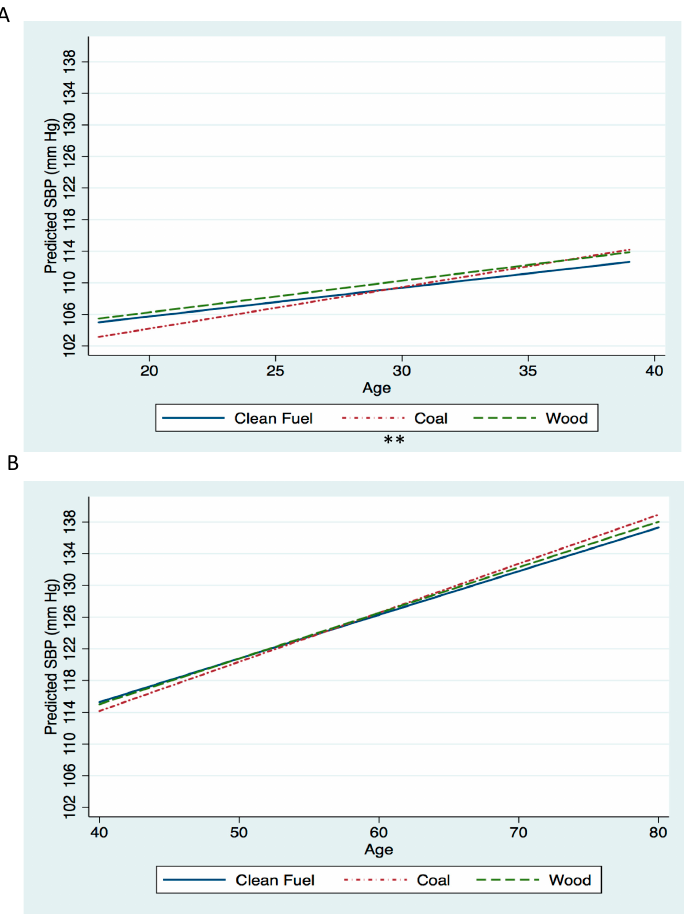
Figure 2. Systolic blood pressure (SBP) by age according to cooking fuel category among nonpregnant women living in rural areas of China (n = 22,118 observations from n = 6671 women, median observations per woman 3). Panel A is the model for women < 40 years of age. Panel B is the model for women ≥ 40 years of age. All models controlled for the following covariates: fuel category, age